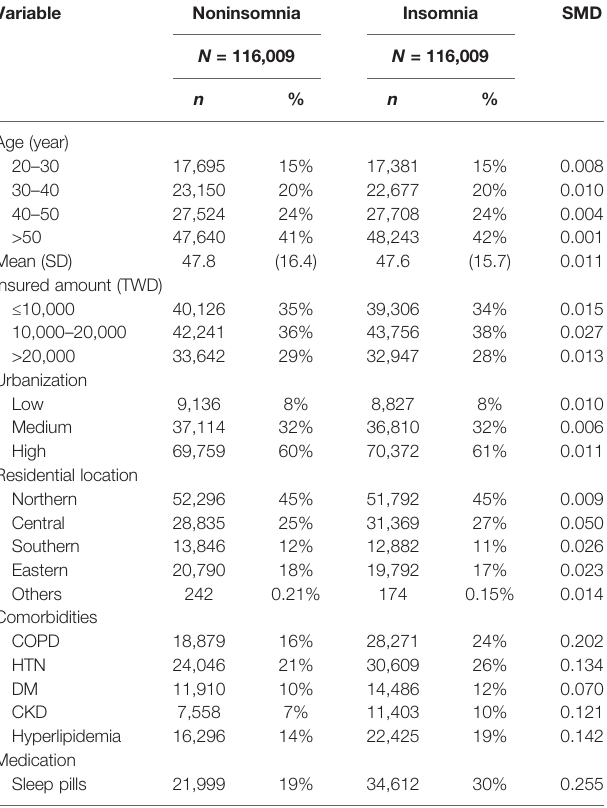
TABLE 1 | The baseline characteristics of patients with and without insomnia. TABLE 2 | The baseline characteristics of patients with and without depressive